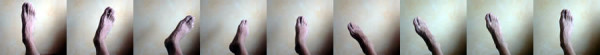
Description of the foot rotation test by which several muscle groups are activated. Besides the muscle activation propioceptive stimuli arise from skin and tendon stretching.